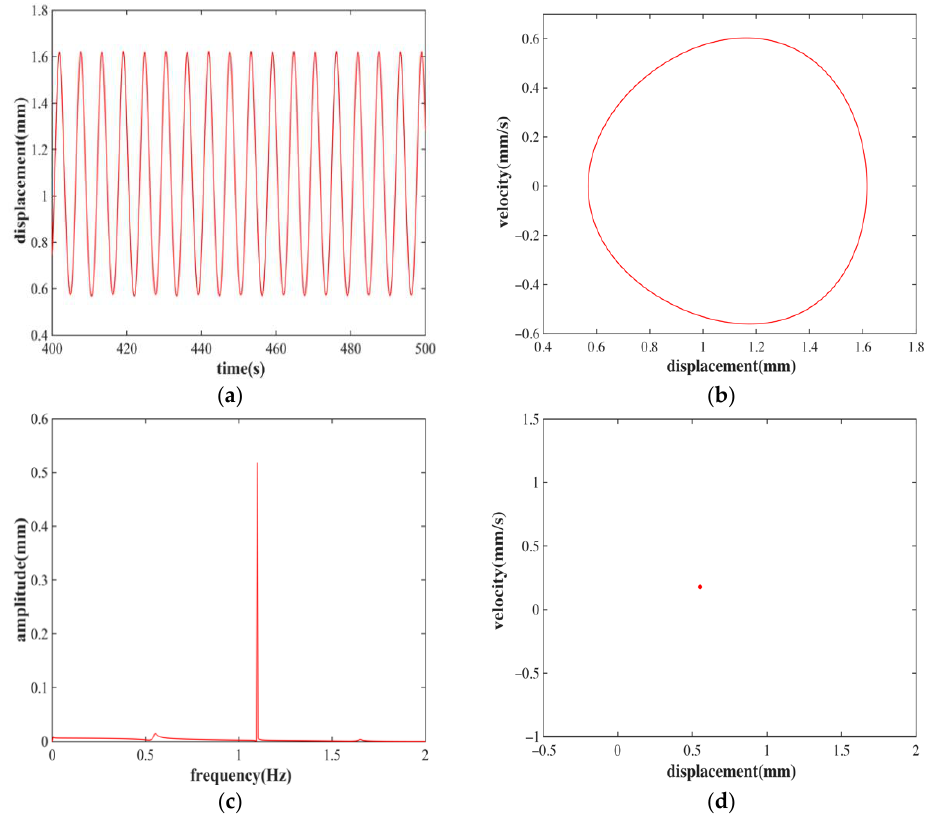
Figure 15. Nonlinear response of the GMA system at α = 0.97: ( a ) Time domain waveform diagram; ( b ) Phase trajectory curve; ( c ) Amplitude spectrum; ( d ) Poincaré diagram.